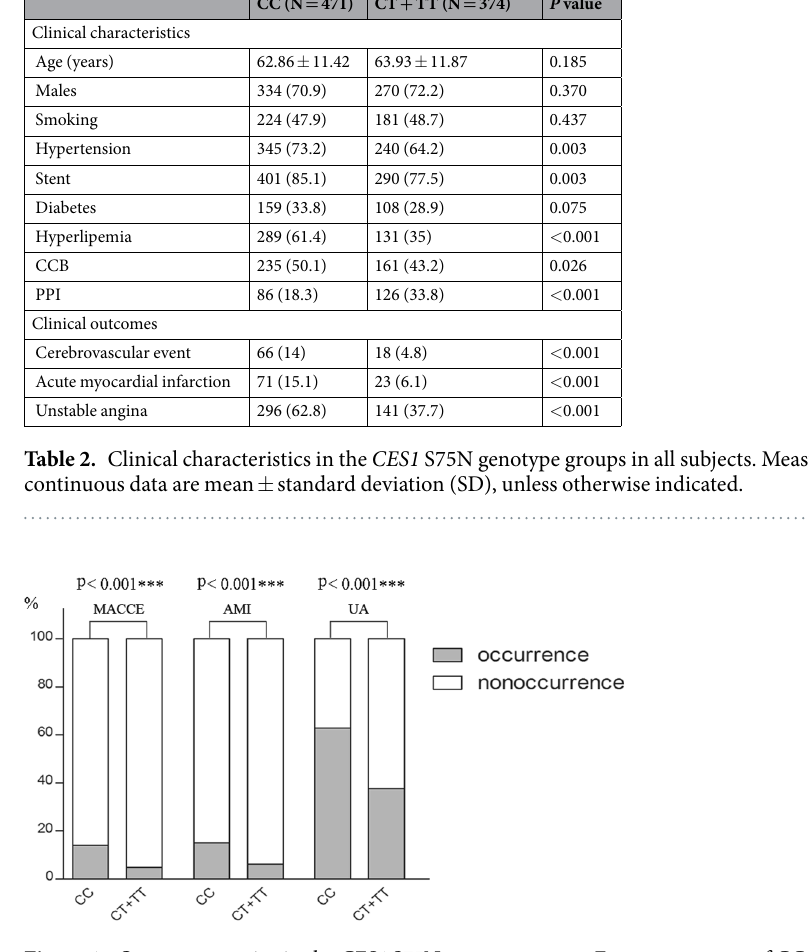
Figure 1. Occurrence ratios in the CES1 S75N genotype group. Fourteen percent of CC group patients and 4.8% of CT + TT group patients had cerebrovascular events after clopidogrel treatment ( p < 0.001). 15.1% vs 6.1% of patients suffered acute myocardial infarction and 62.8% vs 37.7% suffered unstable angina after treatment, respectively ( p < 0.001). The total number of patients in the CC and CT + TT groups was 471 and 374,